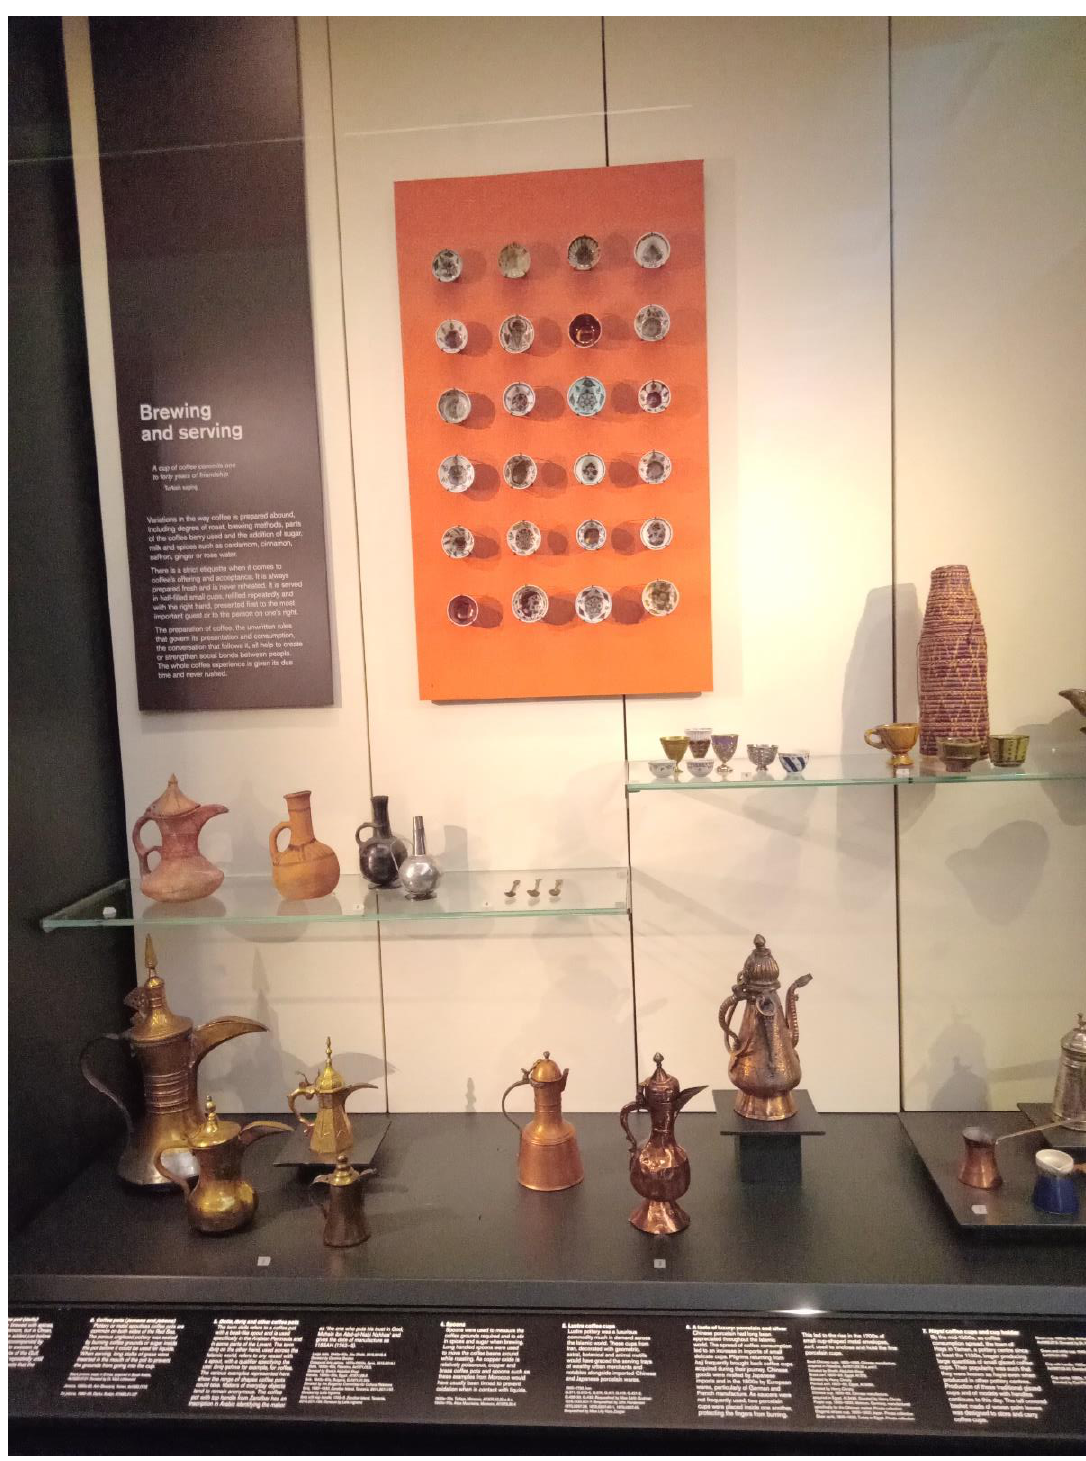
Figure 15. View of the showcasing box “Brewing and Serving” in the Albukhary Gallery, British Museum. Photos of the author.